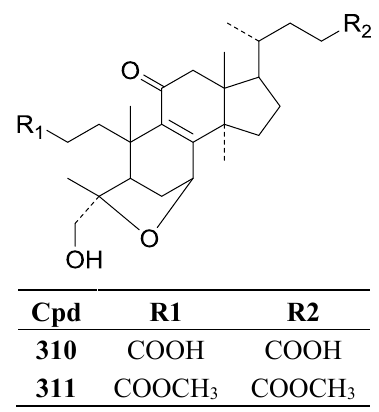
Figure 37. Structure of compounds 310 – 311 .